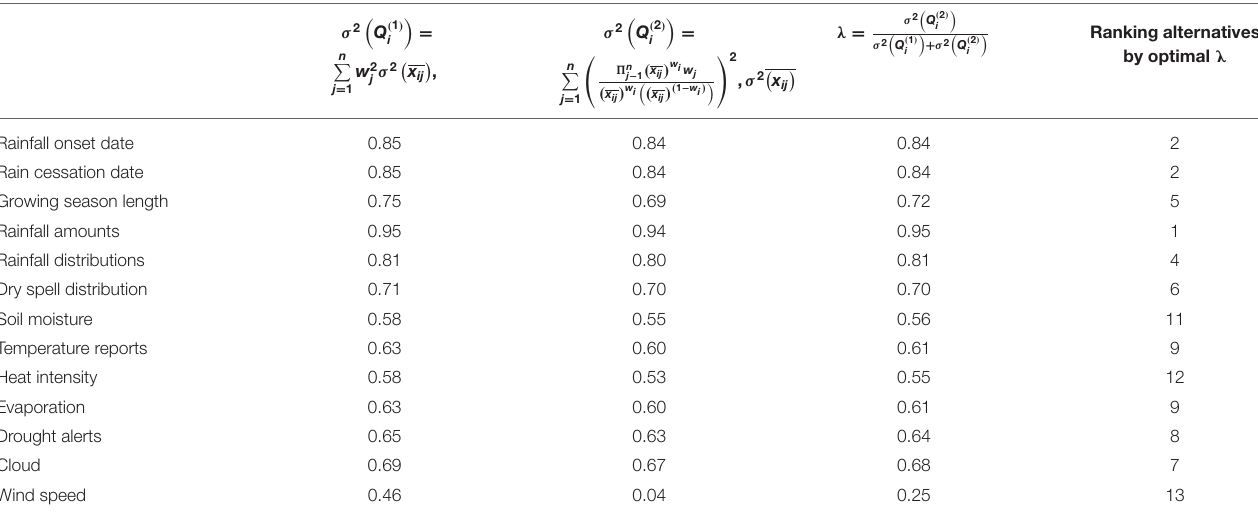
TABLE 11 | Optimality criteria by applying weight aggregation of WASPAS